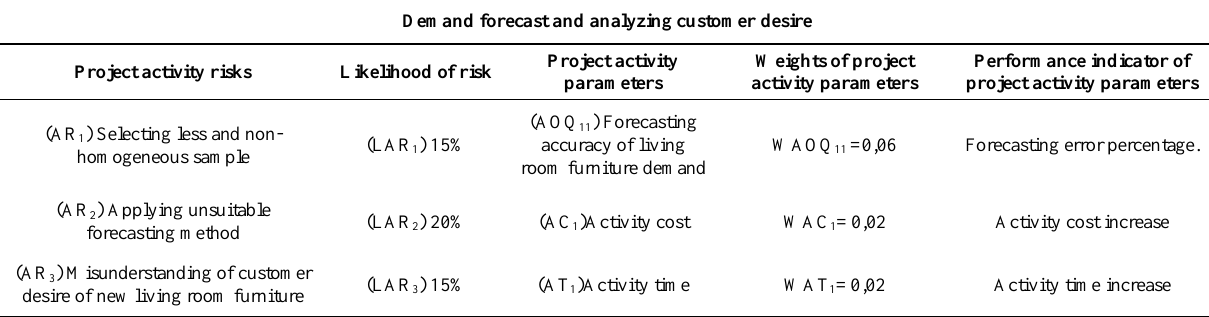
Table 2. TOPSIS table information of demand forecast and analysing customer desire.